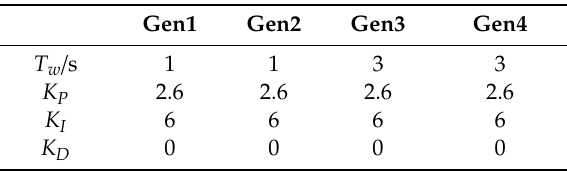
Table 1. The parameters of governors and turbines.